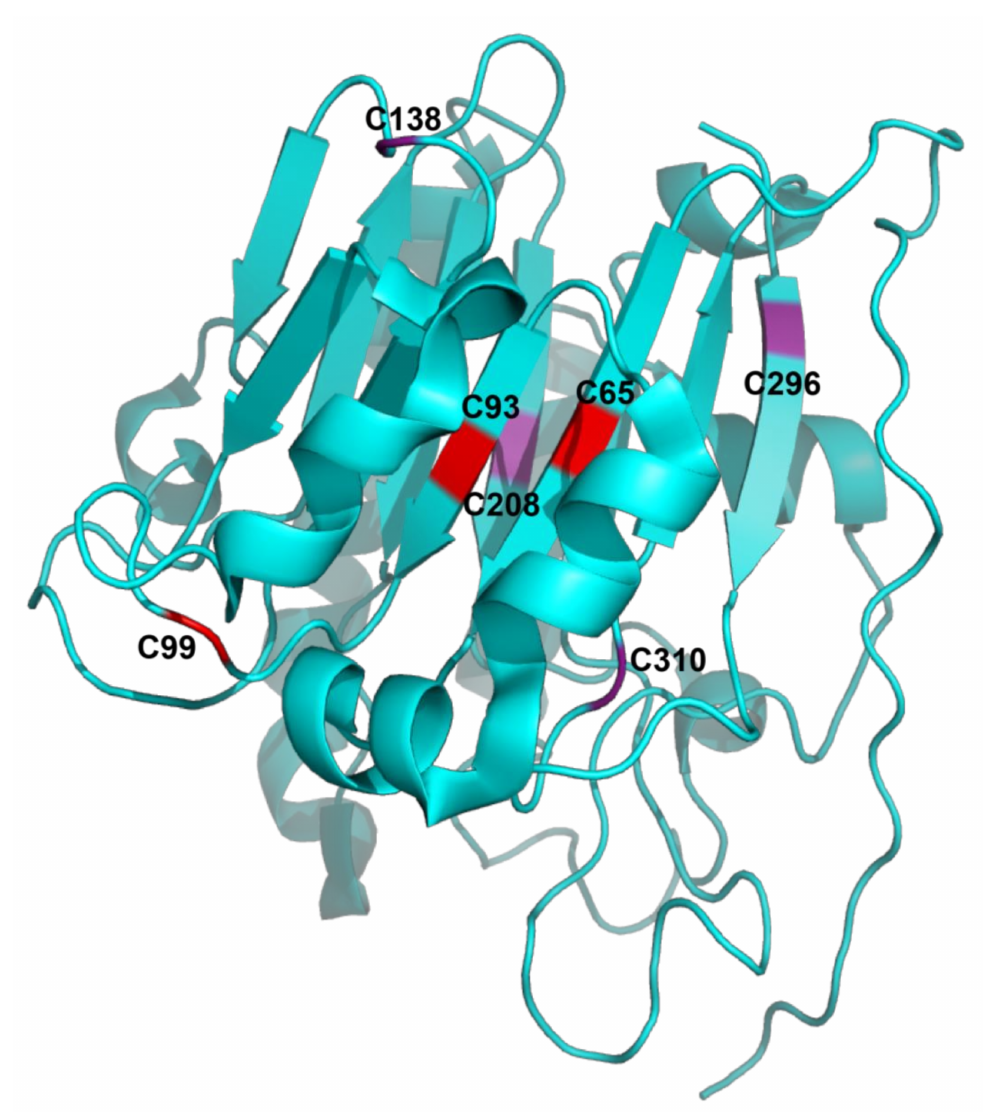
Figure 2. A ribbon rendering of a monomer of APE1/Ref-1 with key cysteine residues necessary for redox activity shown in red (C65, C93 and C99) and additional cysteine residues not necessary for redox activity shown in purple (C138, C208, C296 and C310). Two beta strands contain C65 and C93 and the connecting loop region contains C99. Structure: 4QHD, rendered with Mol*